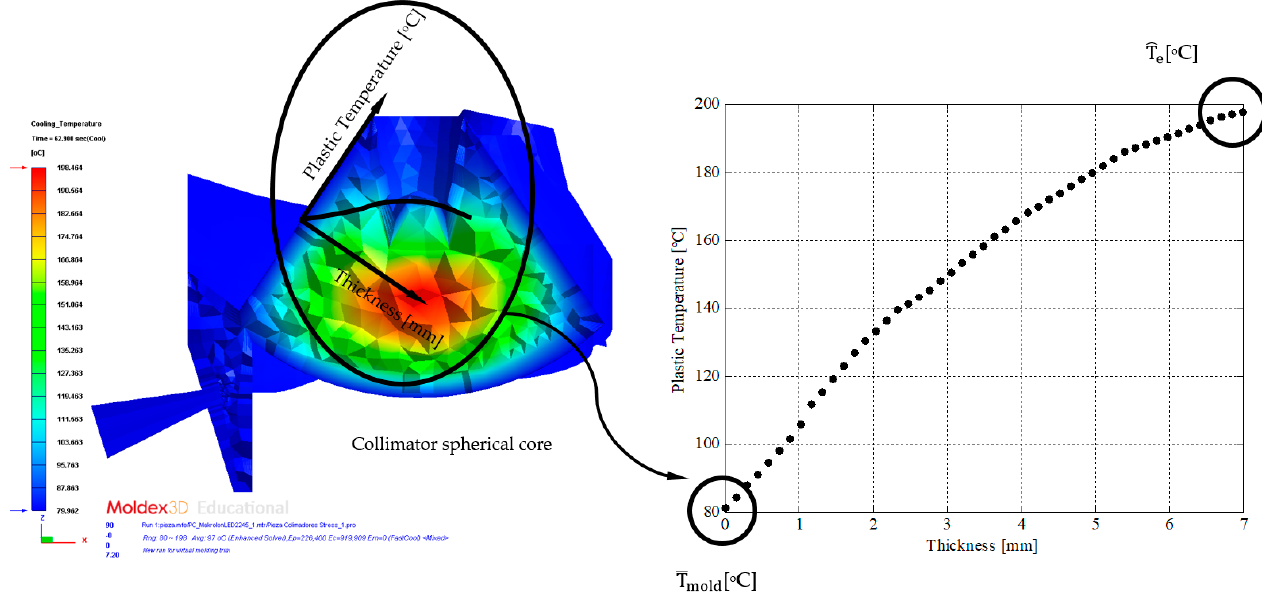
Figure 17. Distribution of the temperature profile of the plastic part [°C] versus the thickness [mm] in the collimator region.